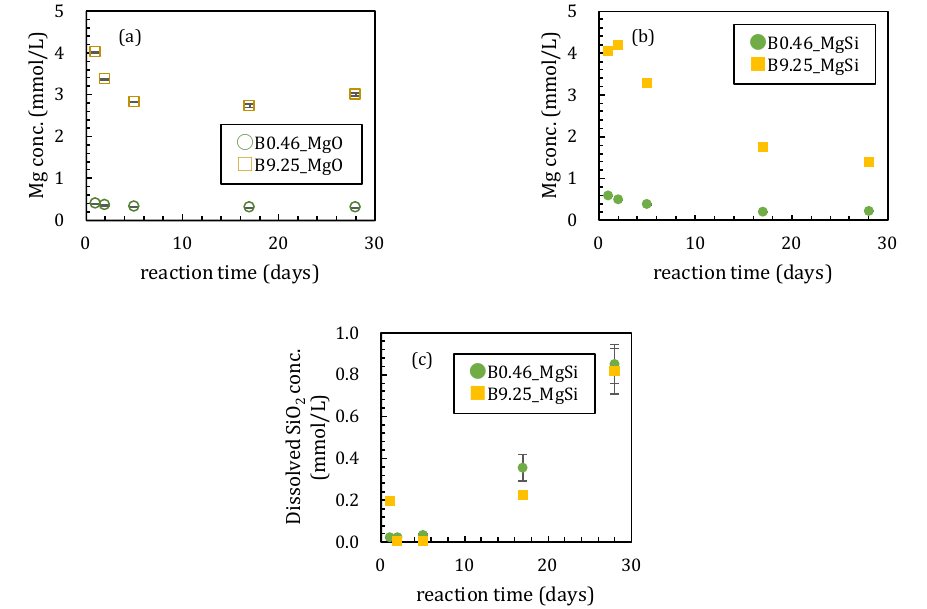
Figure 3. Changes of concentration of dissolved species; ( a ) Mg without amorphous silica, ( b ) Mg and ( c ) SiO 2 with amorphous silica. Data with error bars indicate the standard error of three samples.